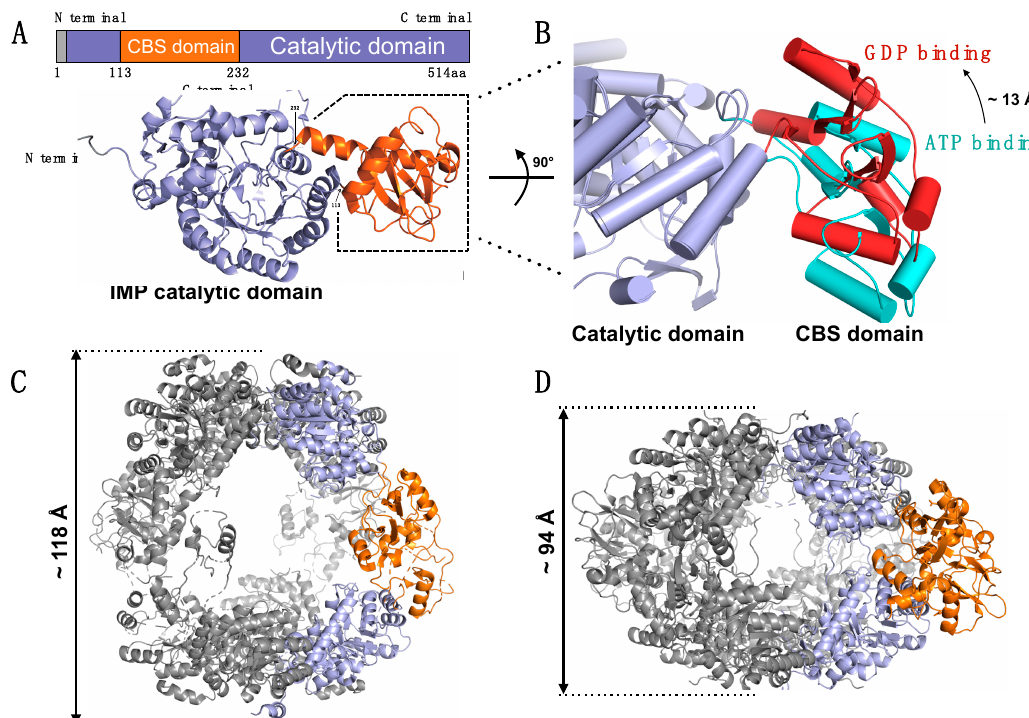
Figure 9. Schematics of IMPDH structures. ( A ) Schematic representation of the human IMPDH2 protein (upper) and monomer of human IMPDH2 structure (lower) (PDB ID: 6i0m). IMPDH structure is shown in cartoons while α -helixes are shown in a coiled model. The CBS domain is colored orange, and the MPDH catalytic domain is shown in light purple. ( B ) Structural changes of the CBS domain upon ATP (Cyan) and GDP (Red) binding in monomeric IMPDH from Ashbya gossypii . Superposed ATP binding (PDB ID: 5mcp) and GDP binding (PDB ID: 4z87) by using C α overlap and 243 aa was aligned. Α -helixes were shown in a cylindrical model. The CBS domain rotated toward an IMPDH catalytic domain (light blue) significantly when GTP binds to the CBS domain, compared with ATP binding. ( C,D ) Different octameric forms between ATP binding ( C ) and GTP binding ( D ). Two monomers of octameric IMPDH (Gray) are colored orange (CBS domain) and light purple (catalytic domain). The approximate longitudinal dimensions of the octamers are indicated on their side. Comparing to ATP binding ( C ), the interaction changes between CBS domains upon GTP binding made the octameric structure of human IMPDH2 ( D , PDB ID: 6i0o) more compact. Since no ATP-bound structure of human IMPDH has been determined, IMPDH from Ashbya gossypii (PDB ID: 5MCP) is used as the ATP binding model.